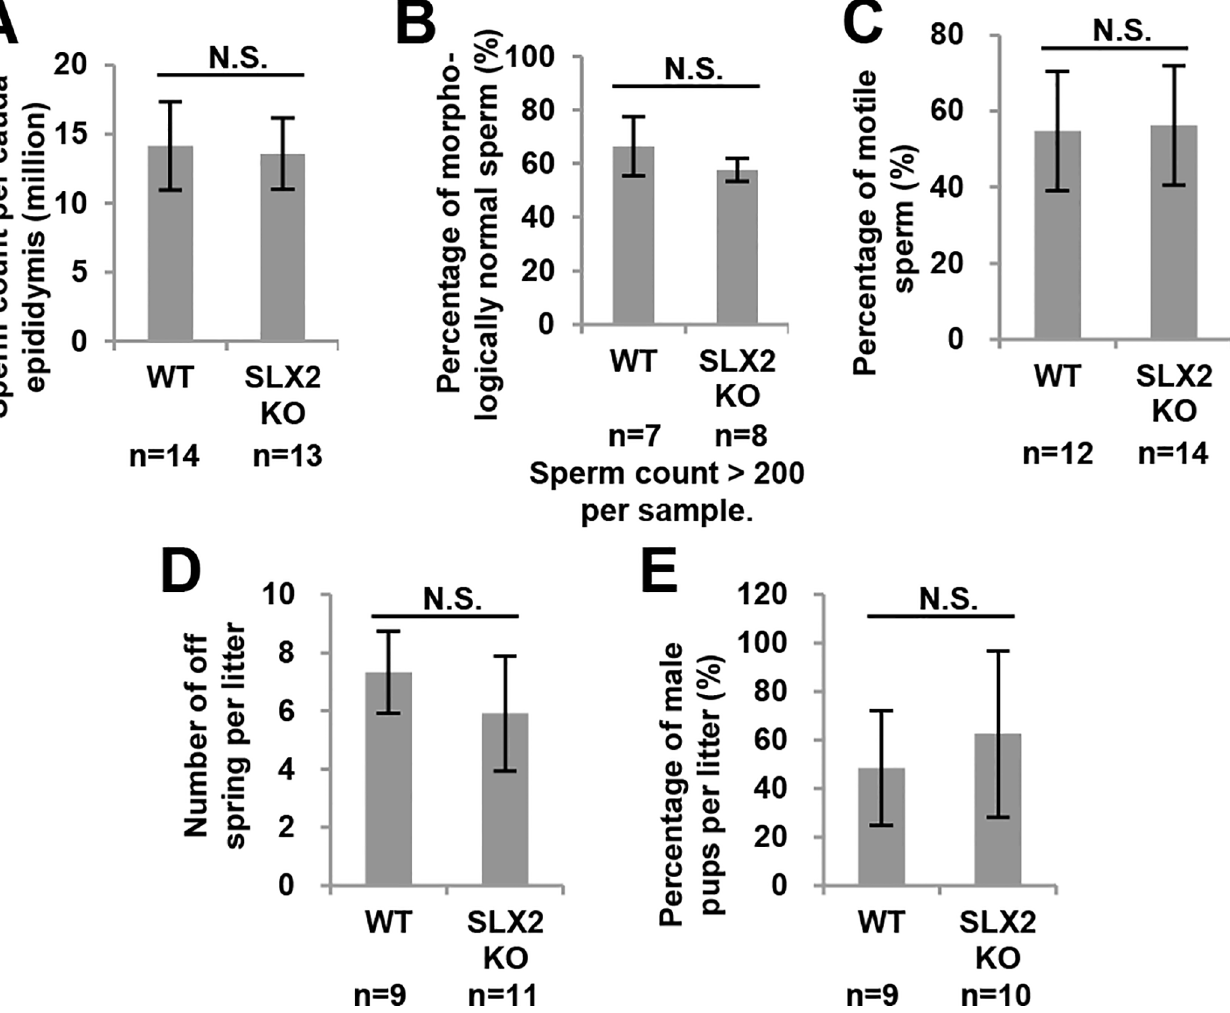
Fig 5. Sperm analysis and fertility test of male Slx2 knockout mice. A) Sperm number per cauda epididymis of 16 to 21 weeks old mice. B) Percentage of morphologically normal sperm in 16 to 21 weeks old mice. C) Percentage of motile sperm in 16 to 21 weeks old mice. D) Number of off spring per litter. E) Percentage of male pups per litter. N.S., not significant; WT, wild-type.